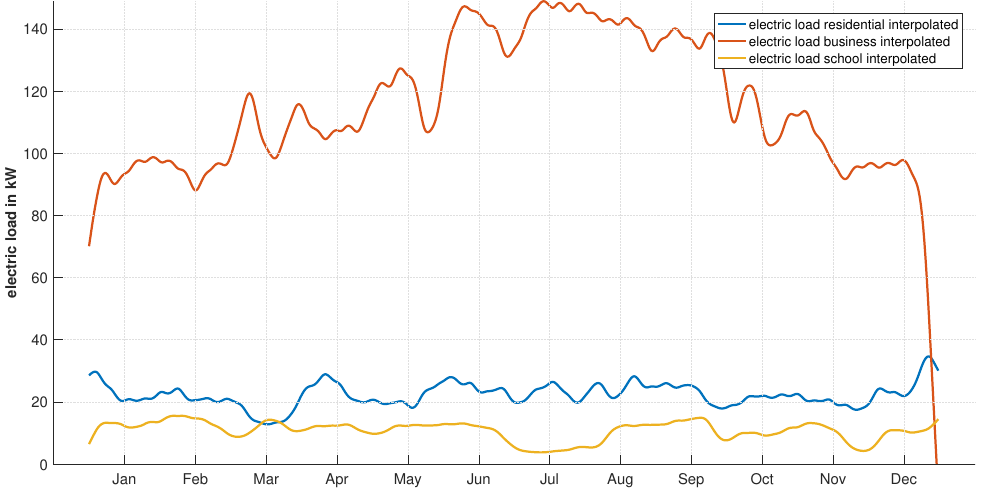
Figure A1. Interpolated electric load of